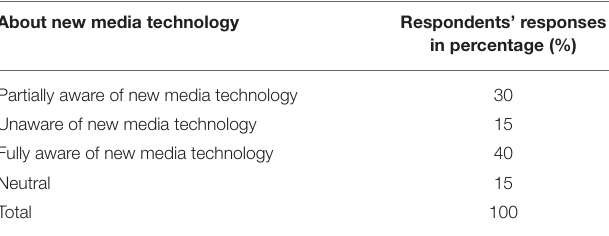
TABLE 6 | Mediating role of engagement and